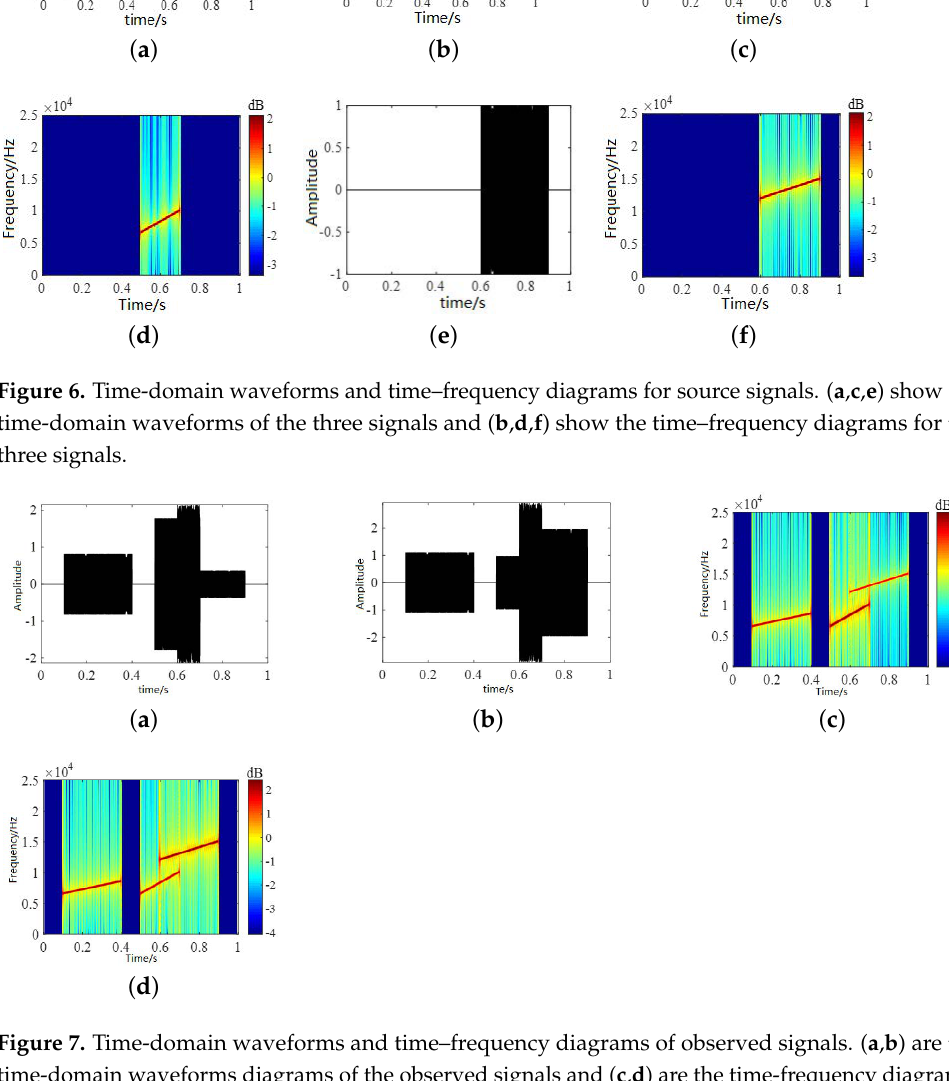
Figure 7. Time-domain waveforms and time–frequency diagrams of observed signals. ( a , b ) are the time-domain waveforms diagrams of the observed signals and ( c , d ) are the time-frequency